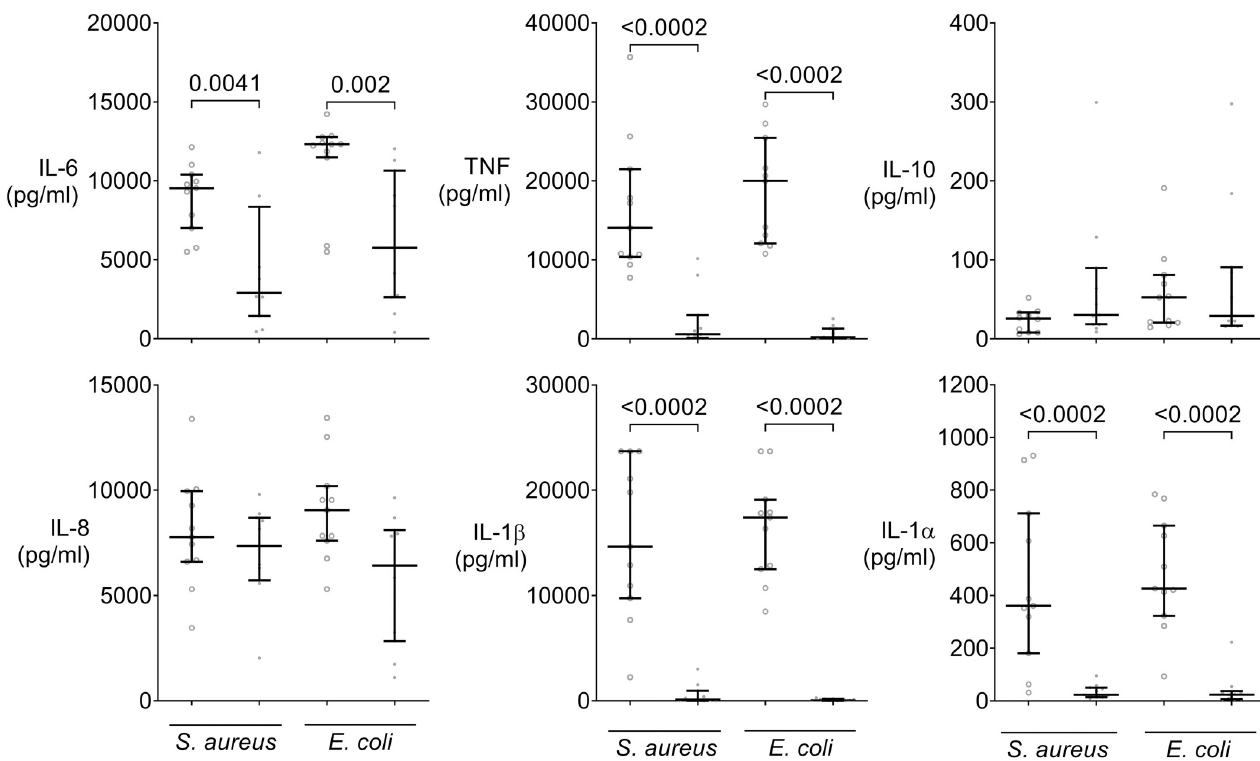
Fig 2. Depressed supernatant inflammatory cytokine concentrations in response to bacteria in early sepsis patients’ whole blood. Supernatant cytokine concentrations in whole blood assays of 11 sepsis patients (dots) sampled within 24 h of meeting Sepsis-3 criteria or matched 11 healthy volunteers (open circles) when incubated for 6 h either with heat inactivated E . coli or S . aureus . Dot plots with median and quartiles. Mann-Whitney tests with Holm- Bonferroni correction for multiple testing. Proinflammatory cytokine concentrations (IL-6, TNF, IL-1 α , IL-1 β ) are markedly less in sepsis patients’ whole blood assays after exposure to bacteria, while there is no difference in anti-inflammatory IL-10